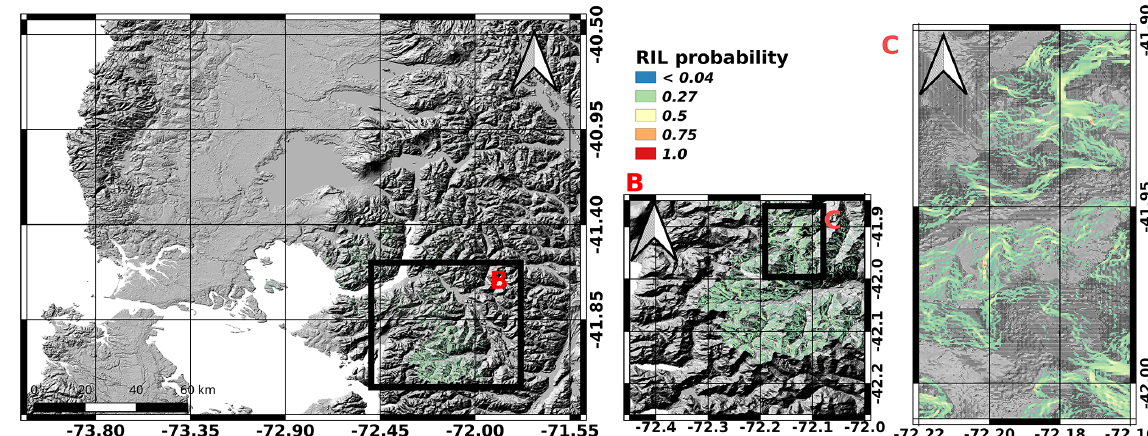
Figure 10. Zones susceptible to RILs for 8 January 2017. Results using Model 1 (probit). Hillshade based on SRTM